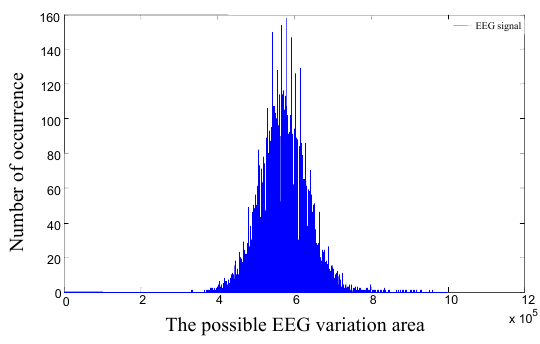
Fig. 7: Histograms of EEG sample captured by channel 3.